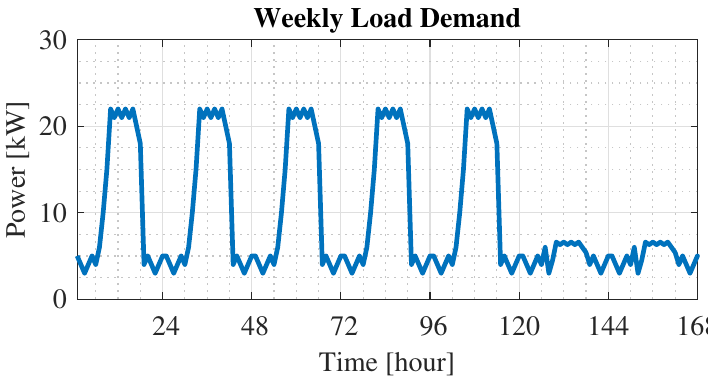
Figure 2. Office power consumption with five weekdays and two days of